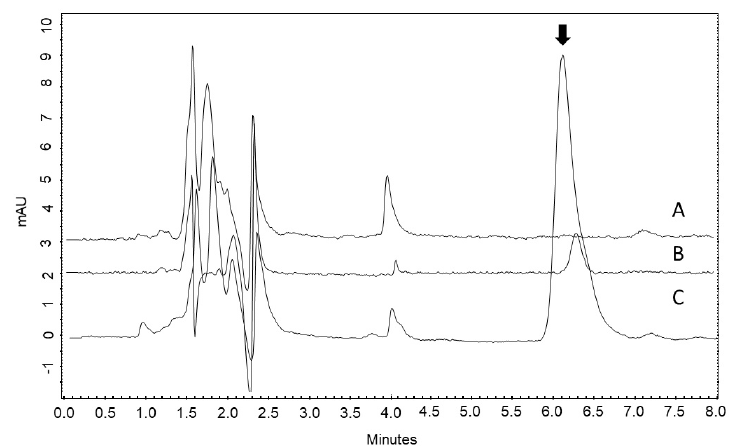
FIGURE 1 - Representative chromatograms of (a) microdialysate blank diabetic rat sample (b) metformin low QC sample (75 ng/ mL) and (c) liver microdialysate sample (1172 ng/mL) 1h after i.v. administration of metformin (50 mg/kg) to diabetic rat. The arrow indicates the metformin peak.